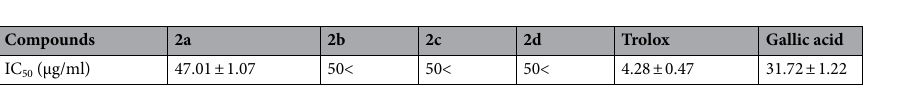
Table 2. Antioxidant activity IC 50 values (µg/ml) of the synthesized compounds, trolox and gallic acid regarding the DPPH test.